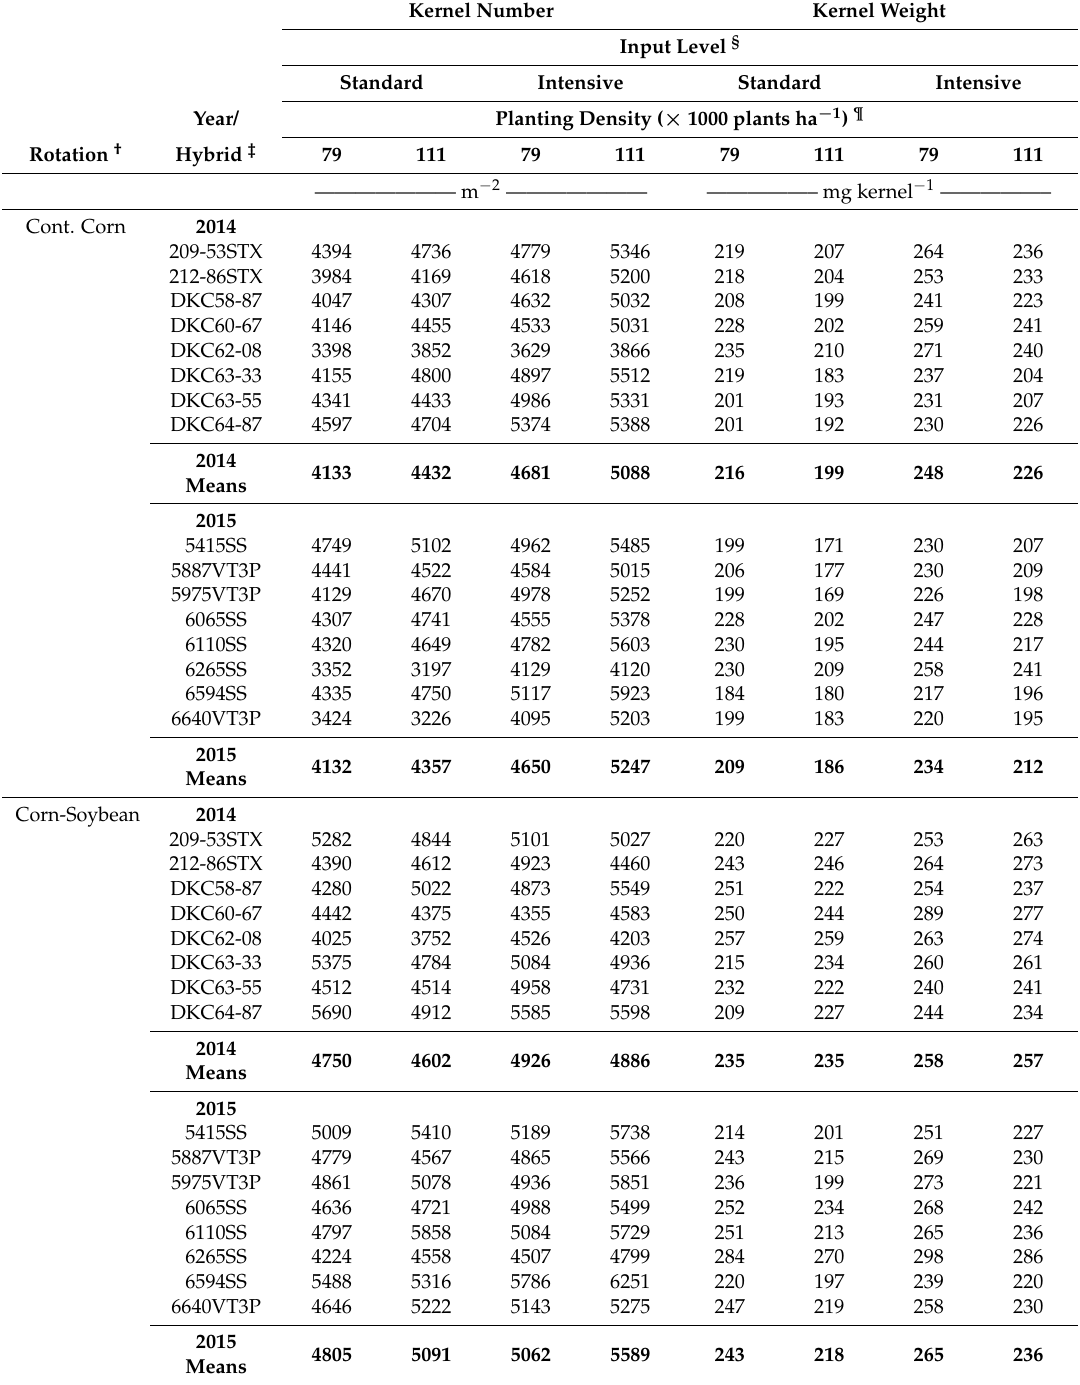
Table 6. Grain yield components as influenced by crop rotation, hybrid, agronomic input level, and population at Champaign, IL in 2014 and 2015. All values are reported at 0 g kg − 1 moisture